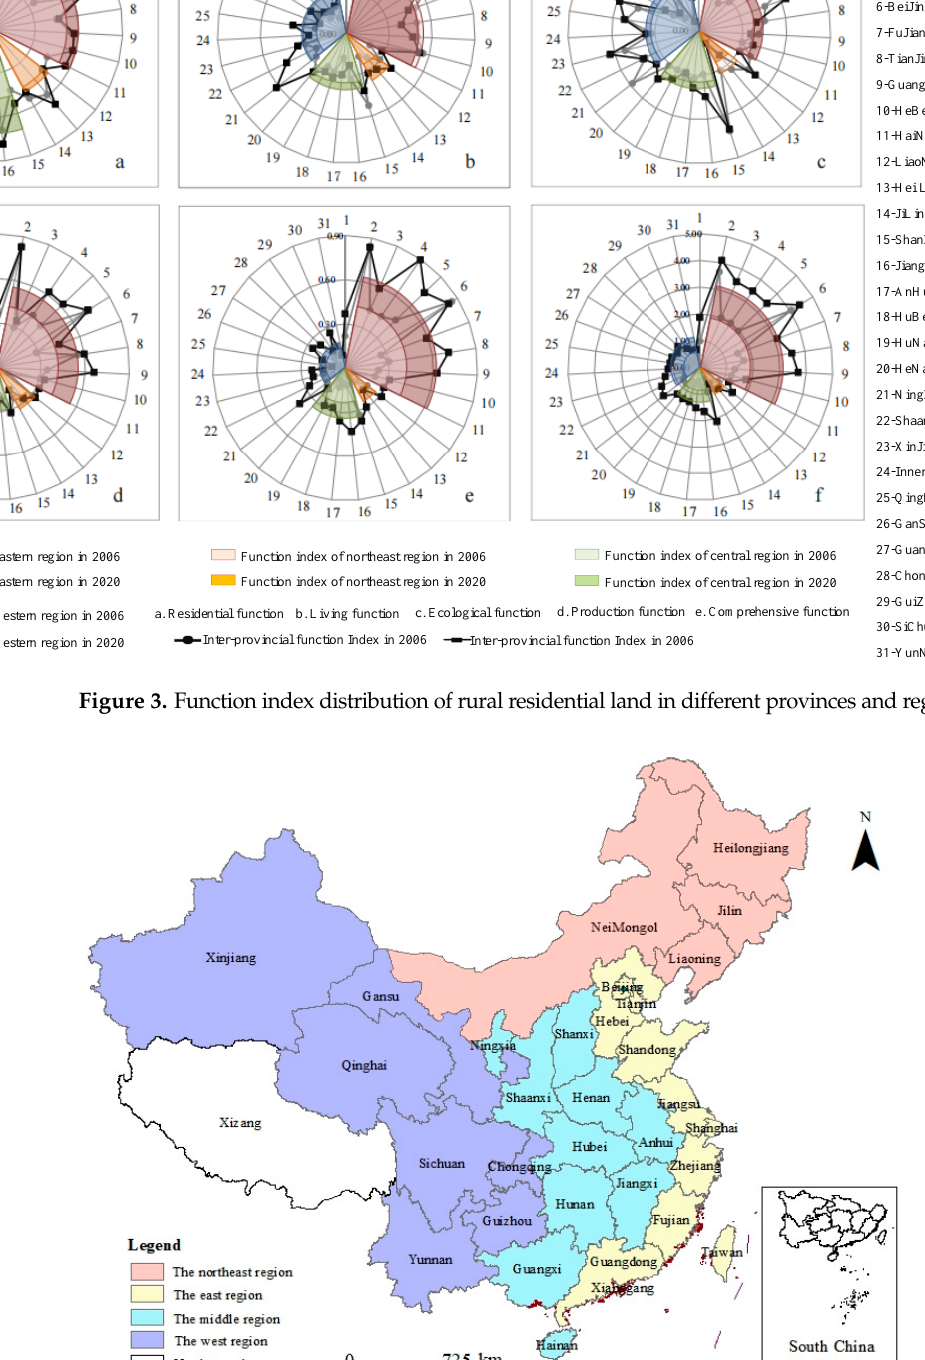
Figure 4. Map of the administrative divisions of China.